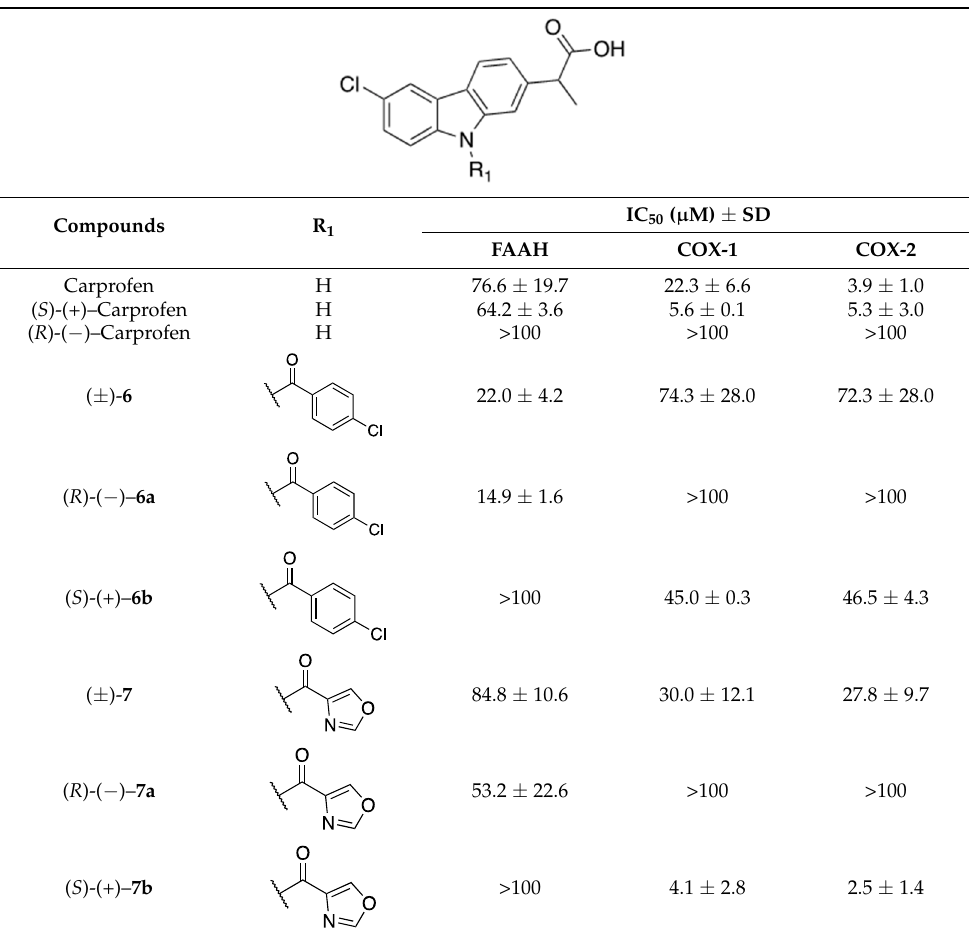
Table 4. FAAH, COX-1, and COX-2 activities of racemic and single enantiomers of carprofen, compounds 6 and 7 .